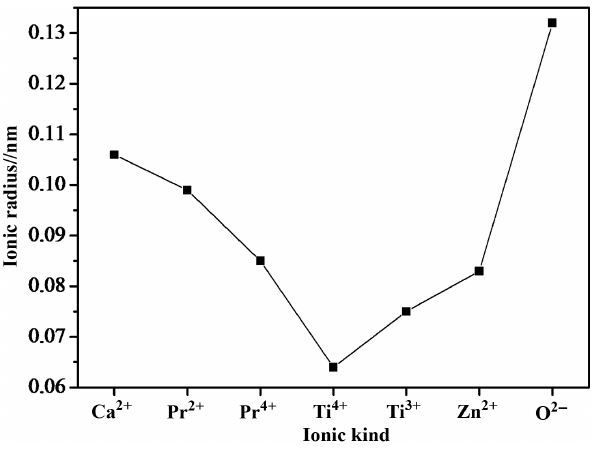
Figure 2: Radius of